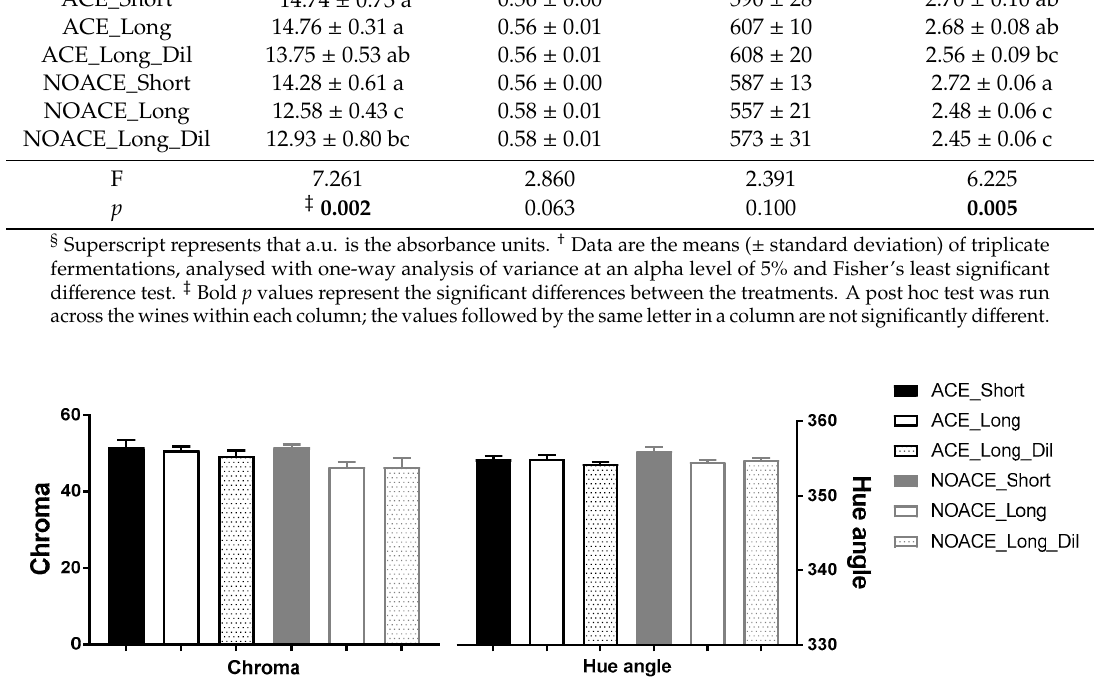
Table 2. Colour measurements by the modified Somers assay of Shiraz wines prepared following the NOACE and ACE maceration with either 3 days (Short) or 6 days (Long) on skins, or 6 days on skins with pre-fermentation water dilution to 13.5 Bé (Long_Dil). § Wine Color Total Anthocyanins SO 2 Resistant Hue (mg / L) Pigments (a.u.) Density (a.u.)